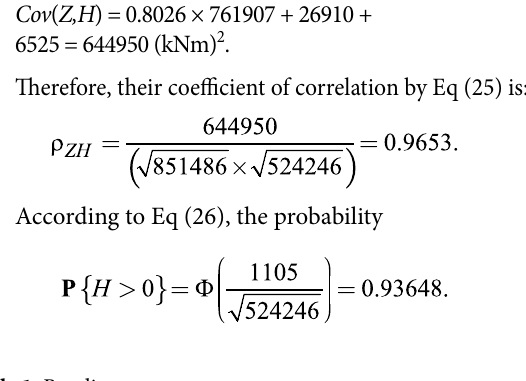
Table 1. Bending moments